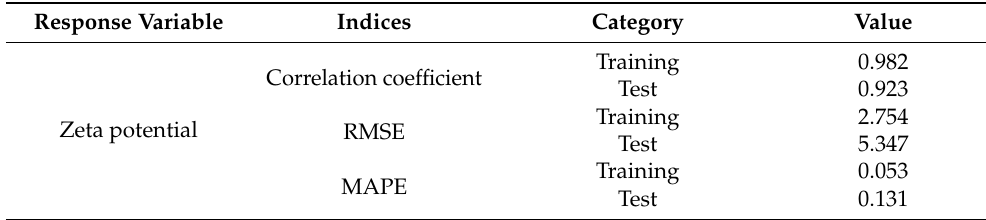
Table 4. ANN model performance